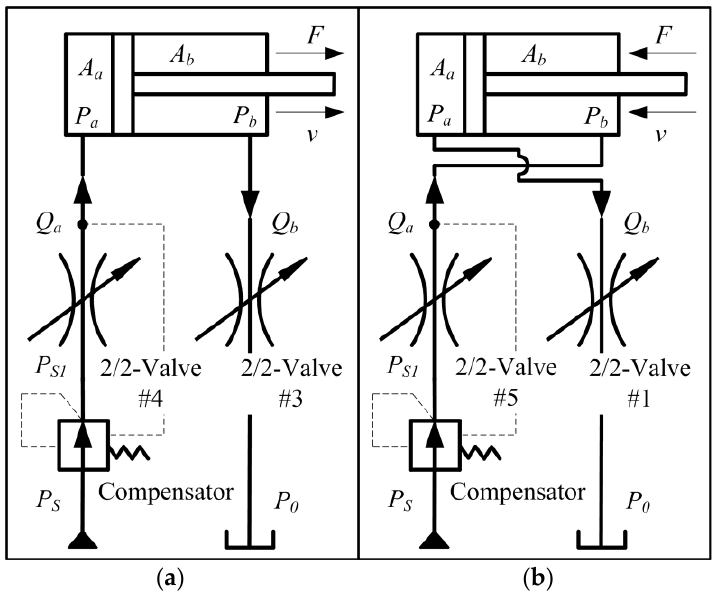
Figure 10. Simplified schematic of hydromechanical pressure compensation independent metering system (HPCIMS) with two working modes. ( a ) Extension working mode, ( b ) retraction working mode.